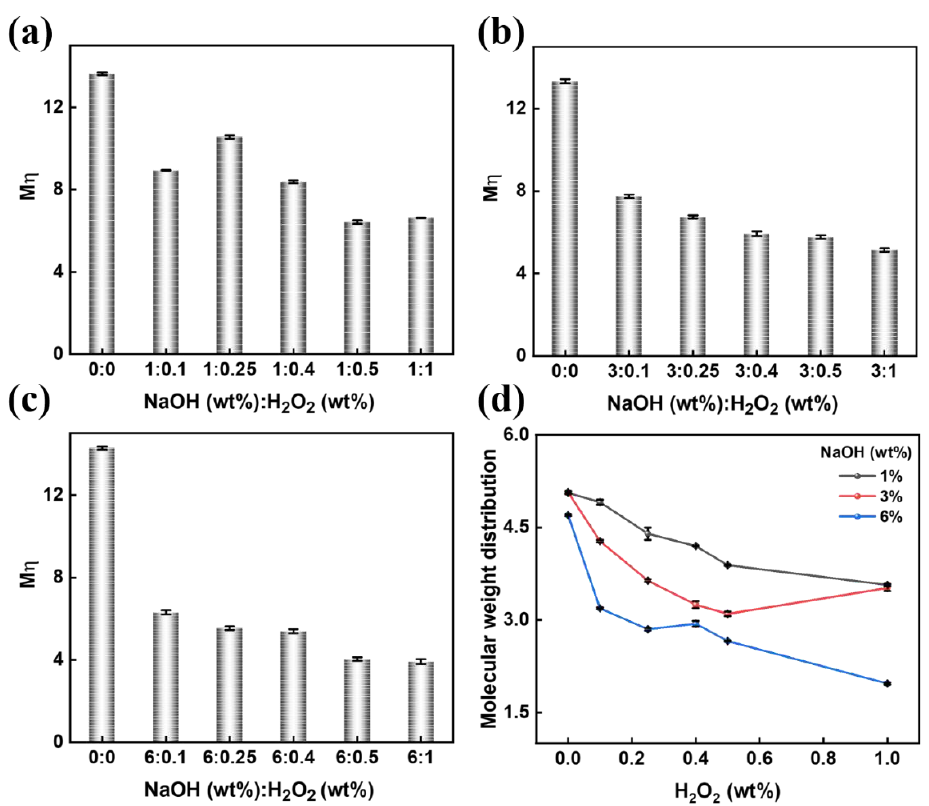
Figure 4. The effect of H 2 O 2 concentration (from 0 to 1 wt%) on M η in the concentration of NaOH, including 1 wt% ( a ), 3 wt% ( b ), and 6 wt% ( c ). ( d ) D Mw/Mn of bamboo cellulose in different NaOH/H 2 O 2 .